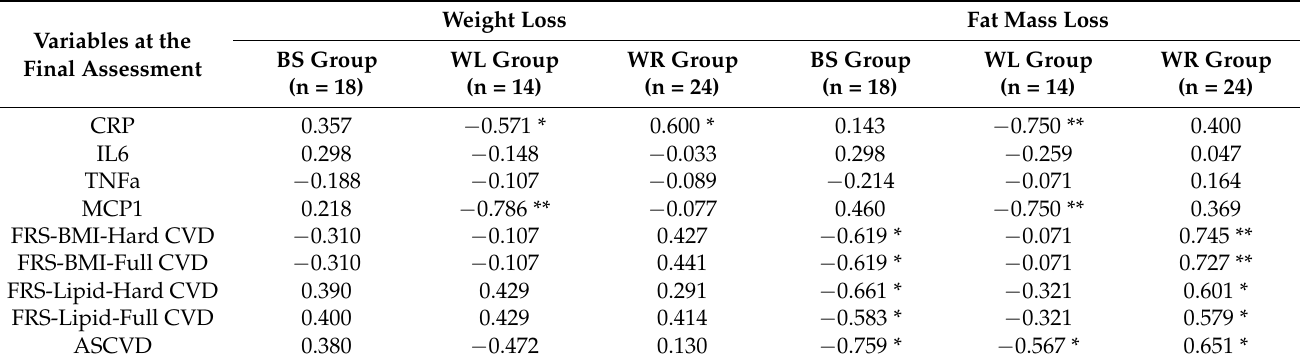
Table 6. The correlation of weight loss with other study variables in study